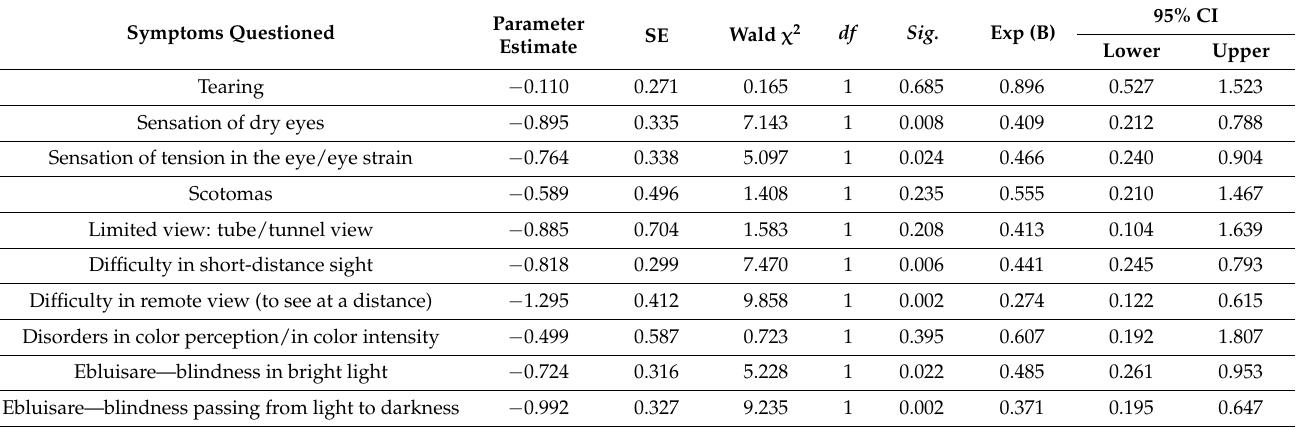
Table 12. Distribution of binomial logistic regression parameters to the symptom questionnaire in OAG (POAG + NTG) and NG